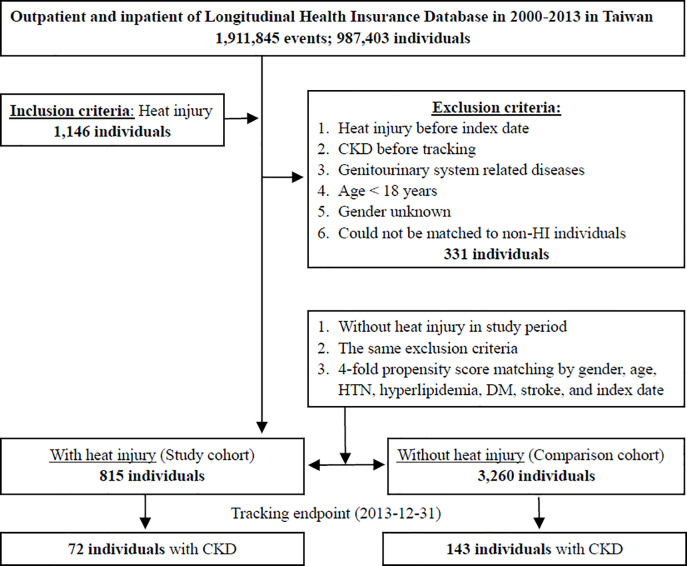
Patient selection flow chart.CKD: Chronic kidney disease.